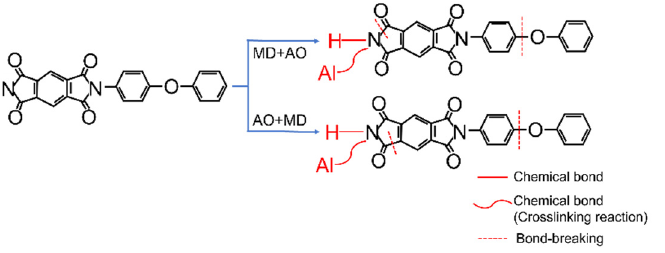
Figure 11. High-resolution XPS spectra of: ( a ) C1s, ( b ) O1s, ( c ) N1s, ( d ) Al2p on Kapton film before and after MD + AO, AO + MD load spectrum.